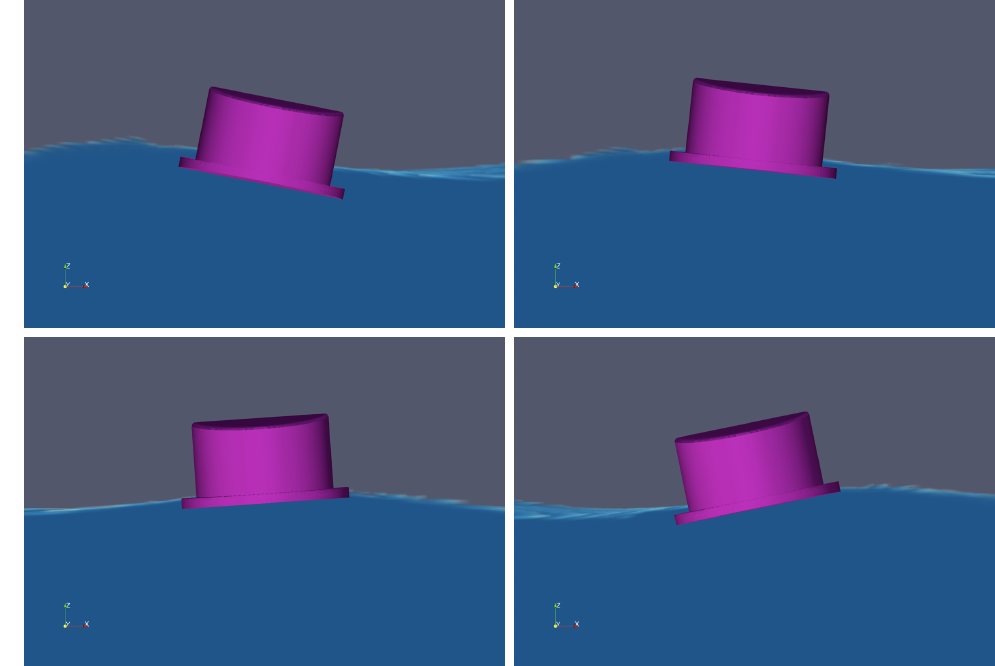
Figure 23. Snapshots of water and the floater H = 13.6 cm and T = 1.4 s, from t / T = 25.5 to